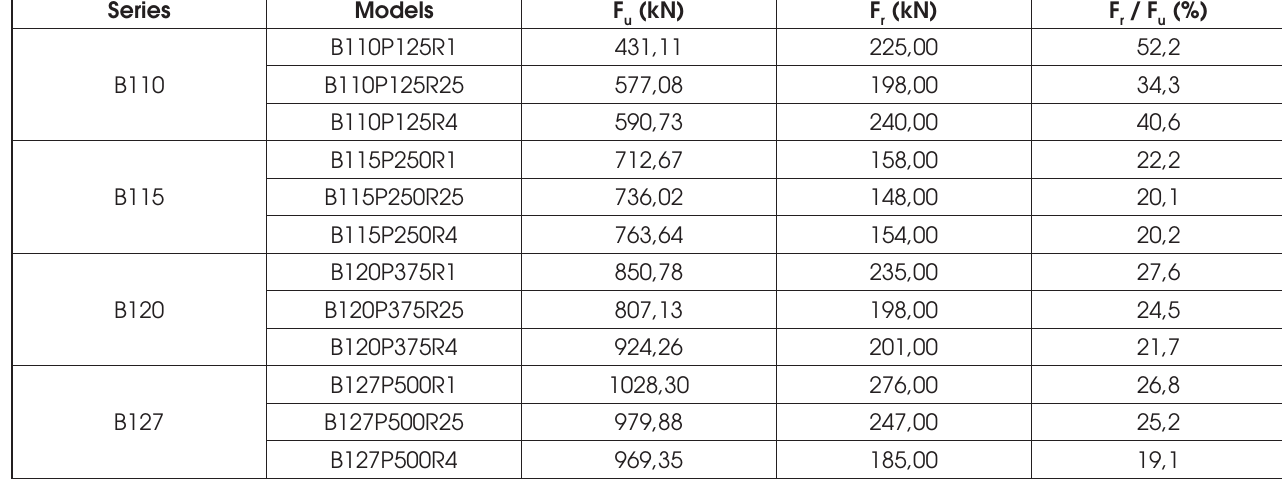
Failure Strength x Strength causes first